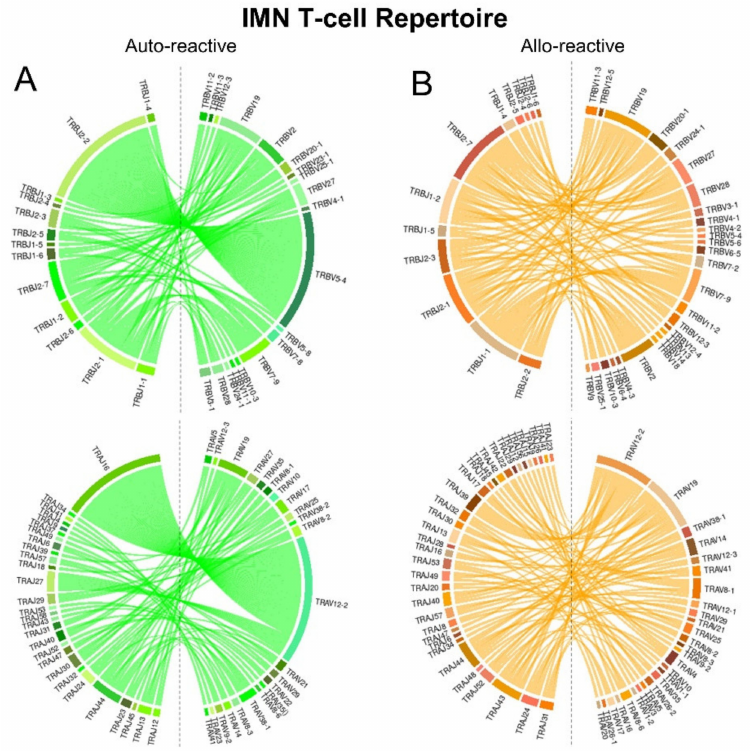
Figure 3. Chord diagrams of IMN-specific ( A ) auto-reactive (green) and ( B ) allo-reactive (orange) repertoires showing TRBV- TRBJ and TRAV-TRVJ pairings. The size of the connections represents an increased frequency of